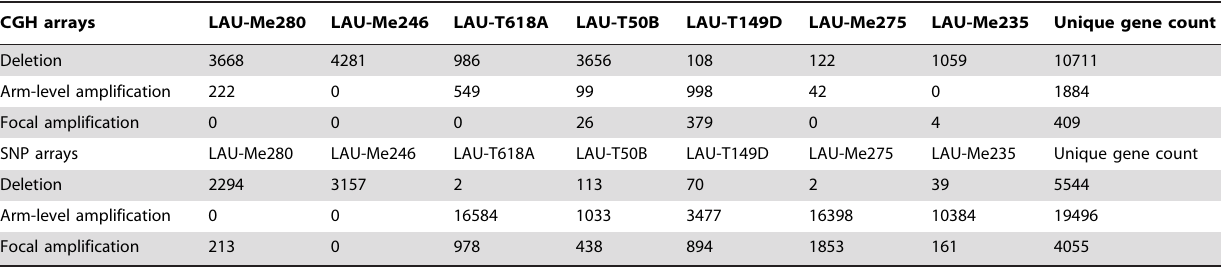
Table 2. Number of genes affected by SCNA in seven melanoma cell lines.